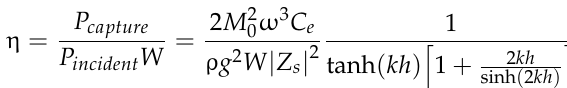
Figure 3. Comparison of hydrodynamic coefficients between the BEM and experimental results for 1:100 scaled Duck at floating state No. 8: ( a ) added inertia; ( b ) radiation damping coefficient; and ( c ) excitation moment coefficient.